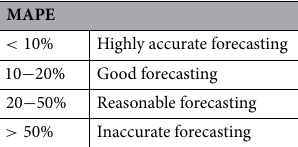
Table 1. MAPE interpretation